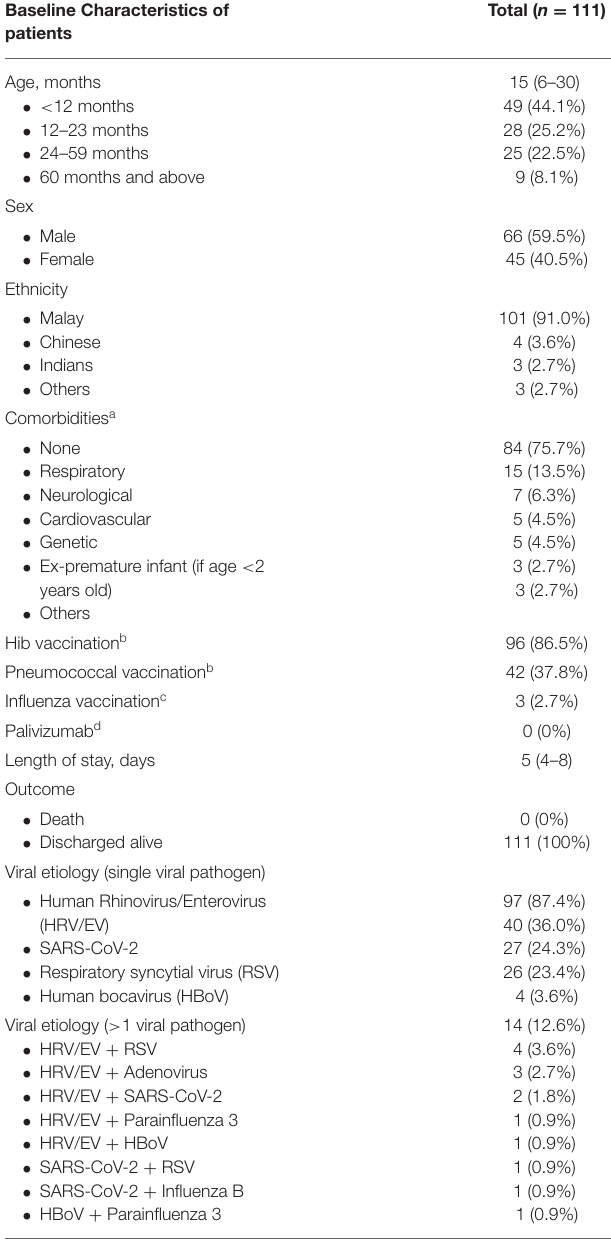
TABLE 1 | Baseline characteristics of the study population. Baseline Characteristics of